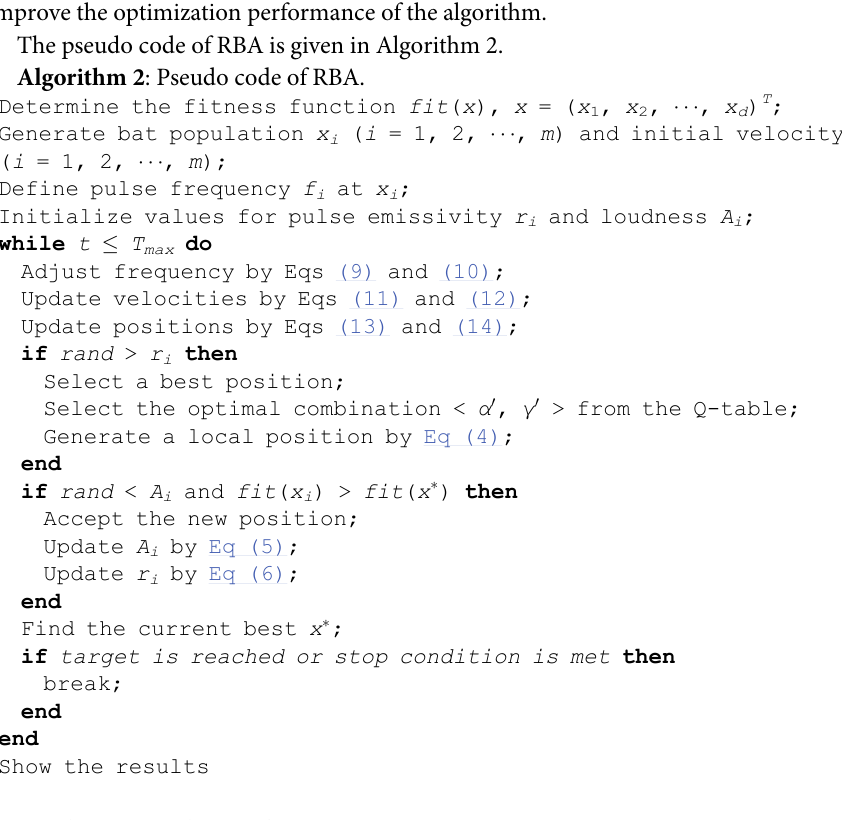
Algorithm 2 : Pseudo code of